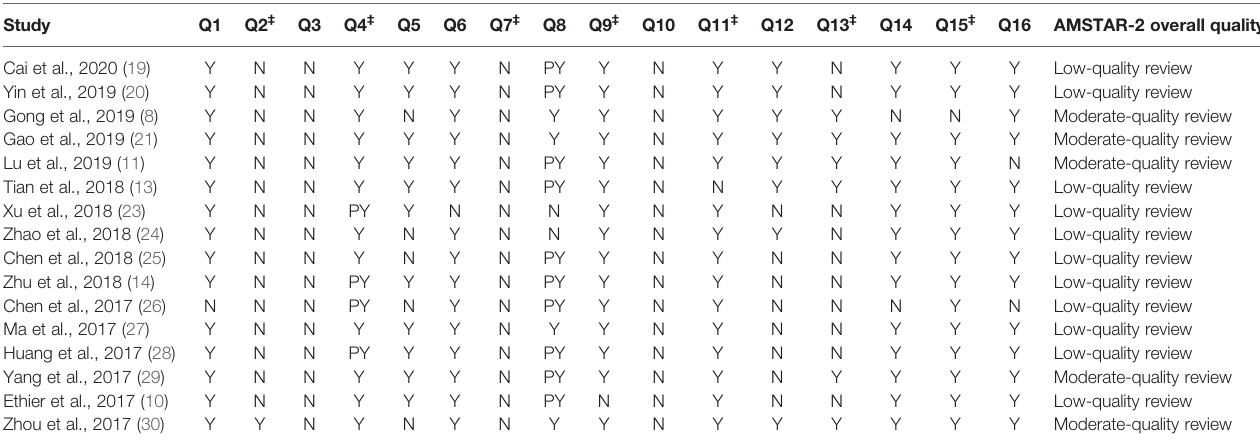
TABLE 4 | Critical appraisal of included meta-analyses based on AMSTAR-2 and evidence grading.